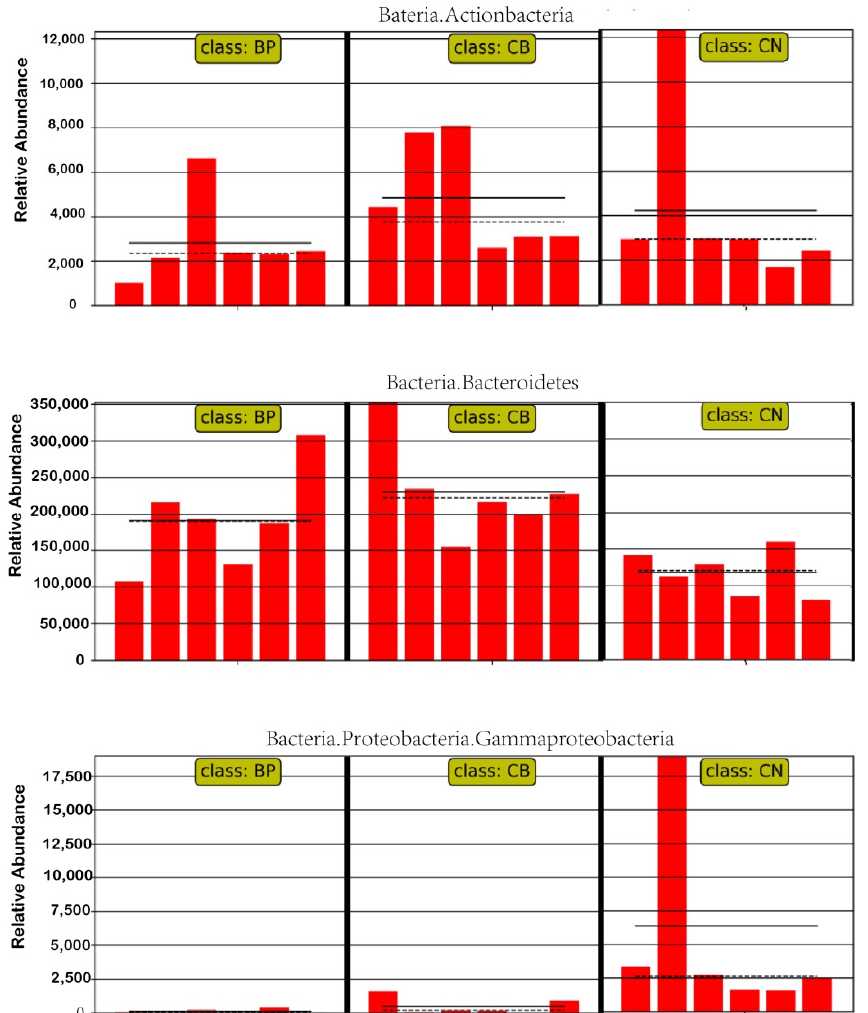
Figure 8. Relative abundance distribution of marker families in different groupings by LEfSe. The mean and median relative abundance values for each taxon in each grouping are identified as solid and dashed lines, respectively. CN, rabbits were fed a basal diet; CB, rabbits were fed a basal diet supplemented with Clostridium butyricum ; BP, rabbits were fed a basal diet supplemented with a bacteriophage cocktail.